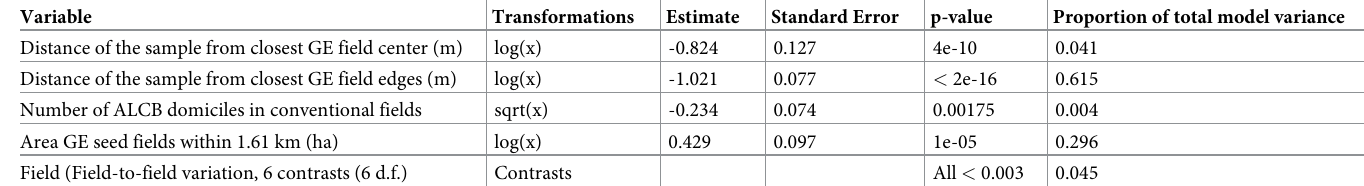
Table 4. Variables explaining gene flow from commercial genetically engineered fields to conventional fields. Parameter estimates of explanatory variables from a stepwise regression procedure on logit transformed proportion of adventitious